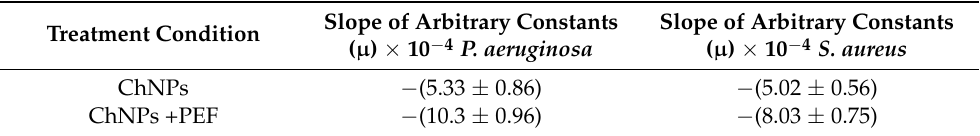
Figure 8. Trend lines of arbitrary constant values for S. aureus treated by ChNPs alone and combined with PEF. Table 2. List of slope trend line values of arbitrary growth rate constants P. aeruginosa and S. aureus treated by ChNPs alone and combined with